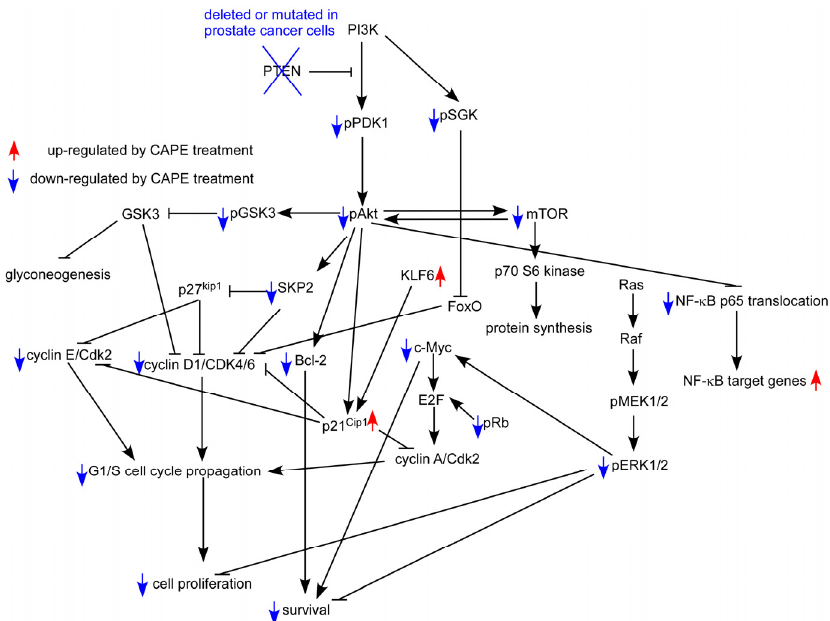
Figure 4. Putative model of anti-cancer effect of CAPE in human prostate cancer cells. Protein abundance or activity being stimulated by CAPE treatment are labeled with red upward arrows, while those being suppressed by CAPE treatment are labeled with blue downward